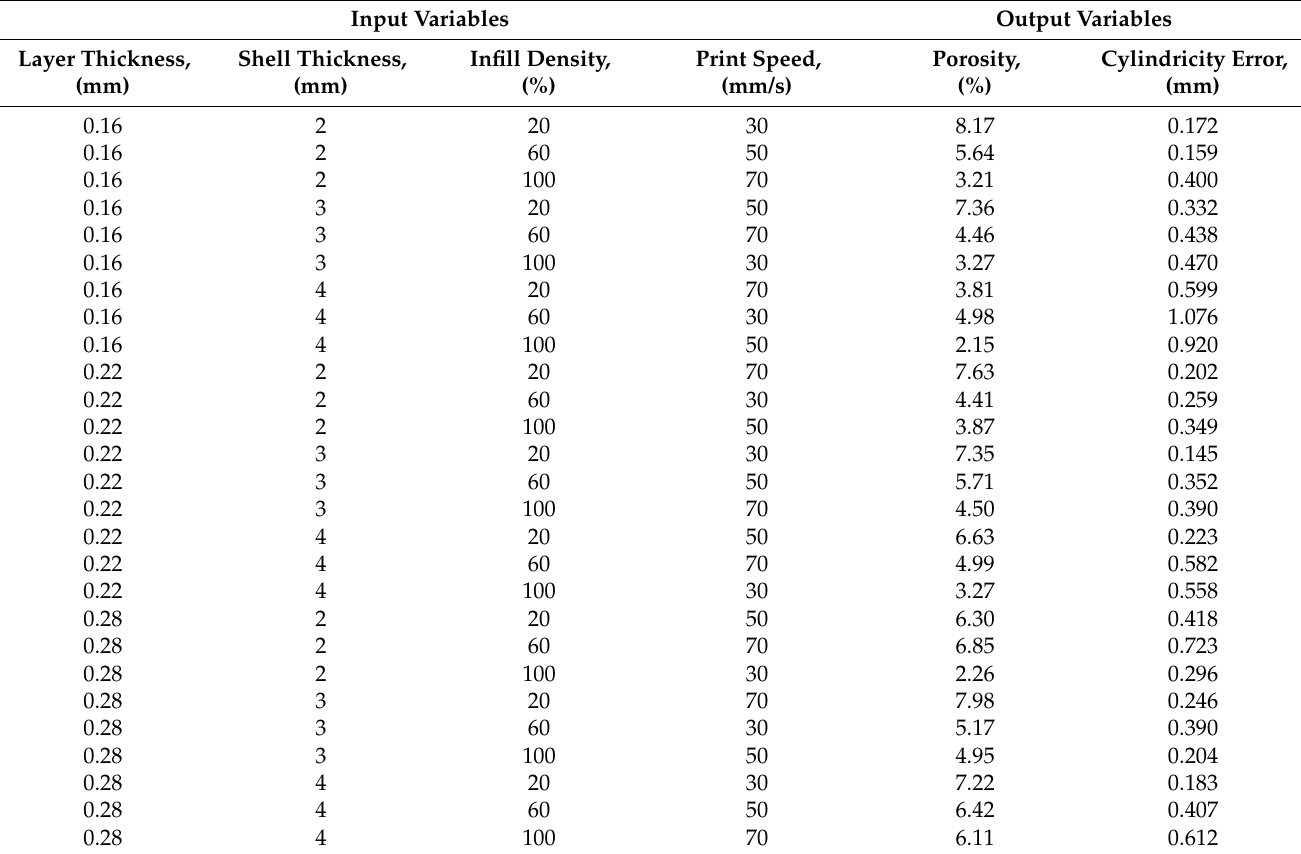
Table 3. Experimental input-output data of the FDM process